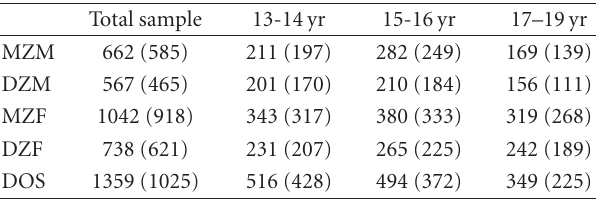
Table 1: Zygosity of participating twin pairs for the total sample and the di ff erent age groups (complete twin pairs added in